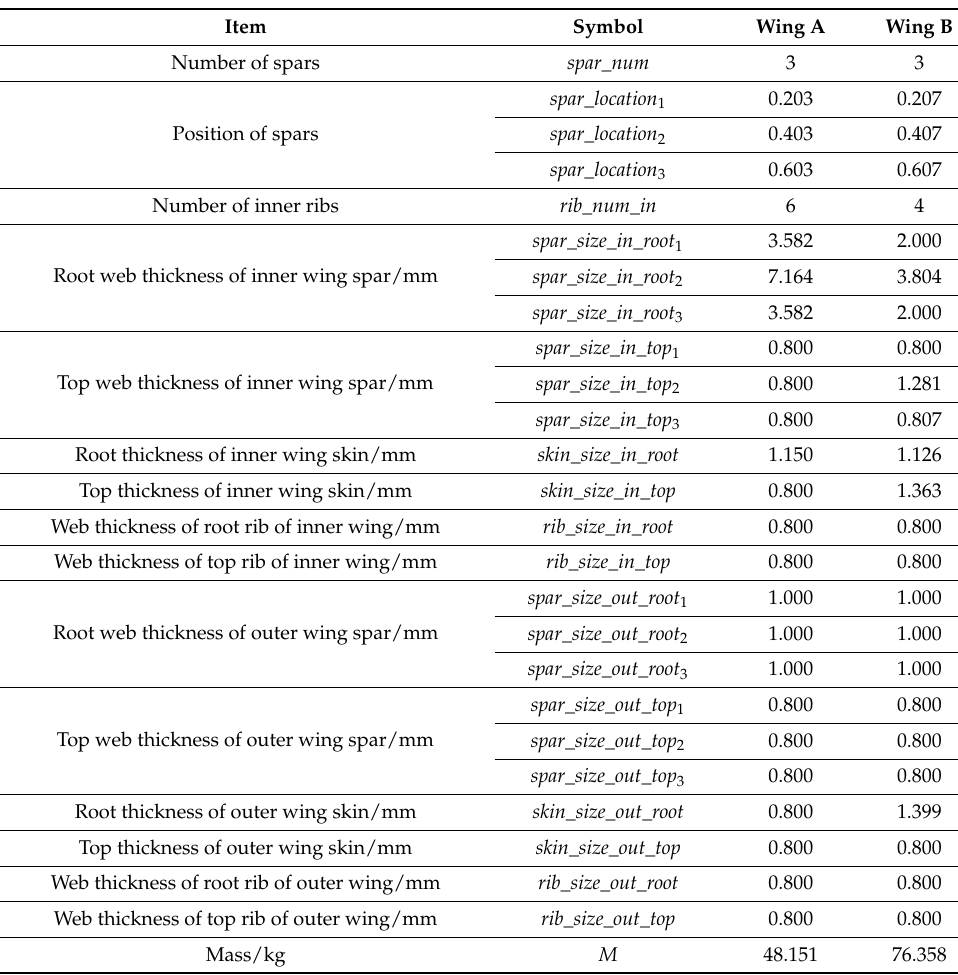
Table 6. Individual optimization